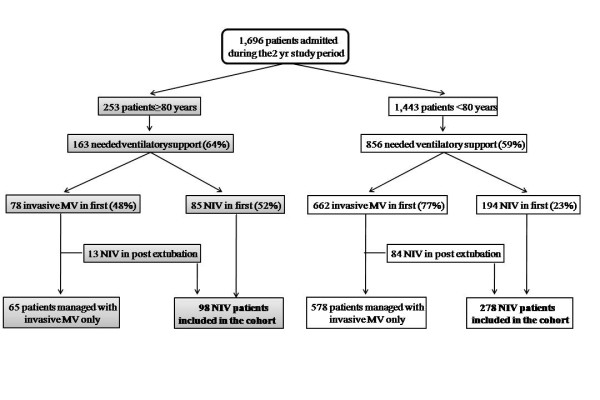
Flow chart of the cohort study.